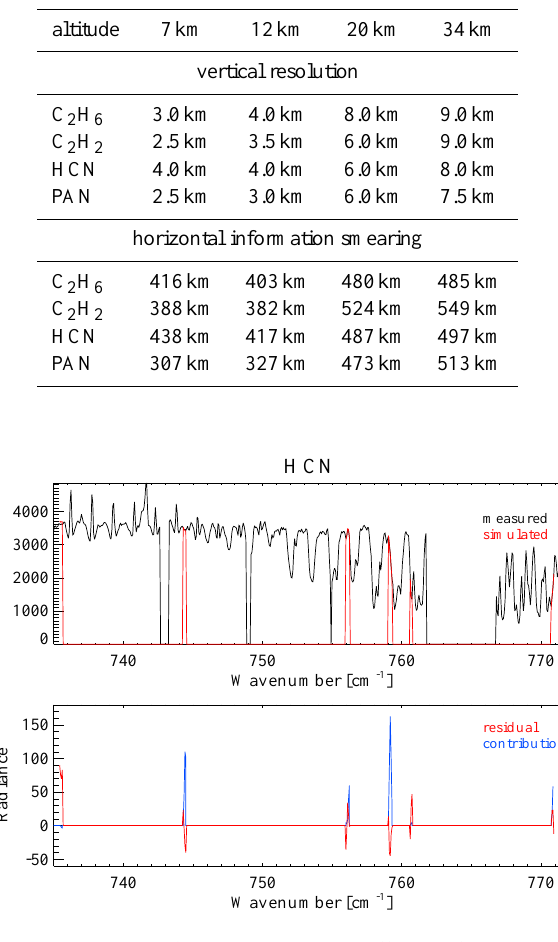
The residual between the measured and the modelled spectrum is plotted in Fig. 6 along with the measured and the modelled spectrum. While NESR is at about 13.4 nW/(cm 2 sr cm − 1 ) the RMS of the residual is at about 40.0 nW/(cm 2 sr cm − 1 ). The spectral contribution of HCN outmatches the residual by up to a factor of three, depending on the particular transition. Random parameter errors are the main error source at most altitudes (see Table 3). Depending on altitude, the error bud- get is dominated by tangent altitude pointing uncertainties, measurement noise, spectral shift, and at a few altitudes